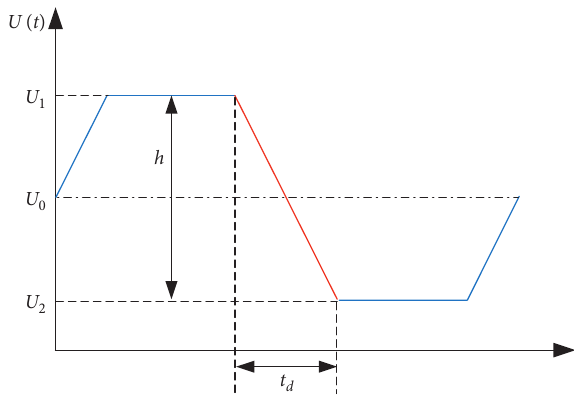
Figure 2: Model of trapezoidal wind